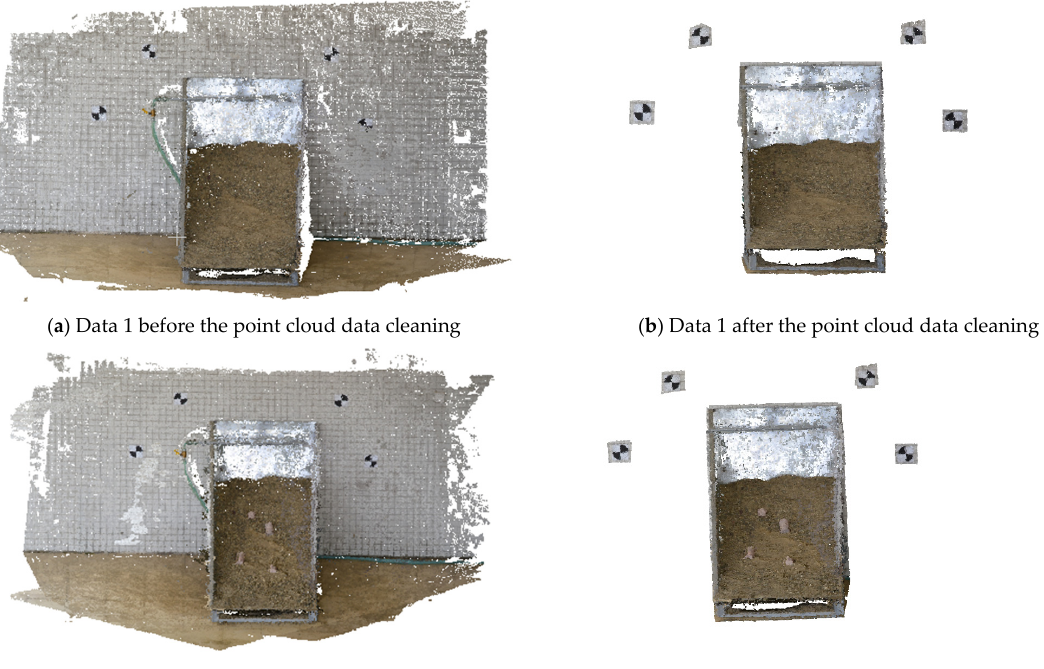
Figure 12. Results before and after the point cloud data cleaning.